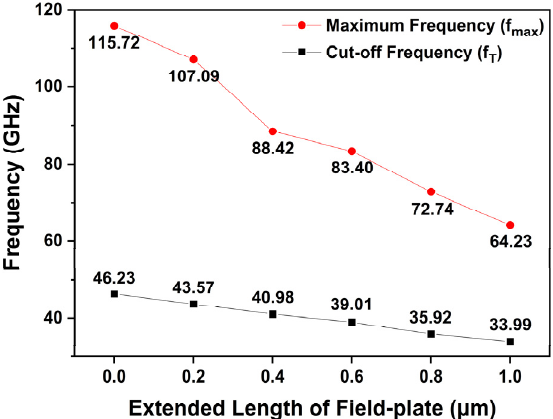
Figure 14. Simulated f (cid:2904) and f (cid:2923)(cid:2911)(cid:2934) as a function of FP length at V (cid:2888)(cid:2903) = 20 V and V (cid:2891)(cid:2903) = –3.2